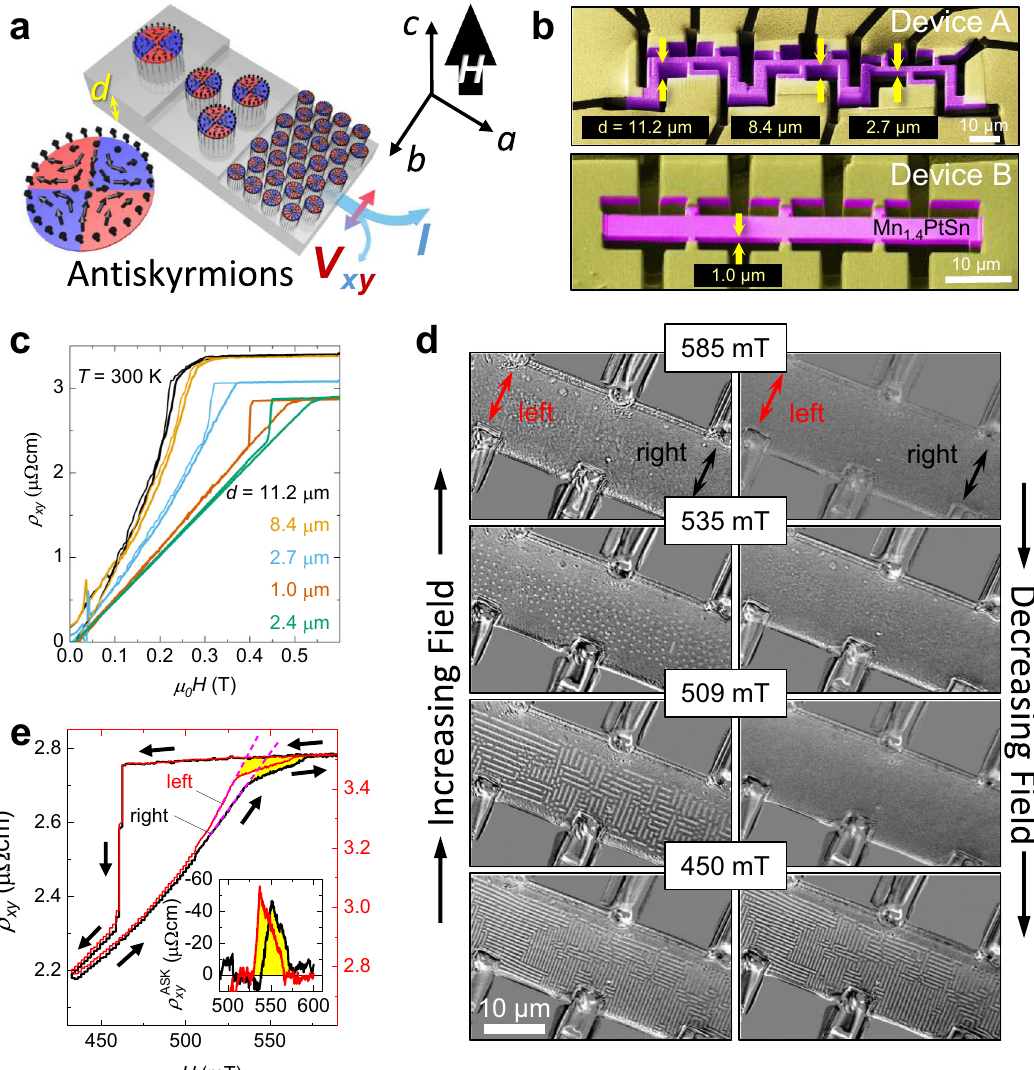
Fig. 1 Transport signature of ASKs in micro-fabricated Mn 1.4 PtSn devices. a Schematic visualization of thickness-dependent ASKs induced by magnetic fi eld, H ∥ c axis, in a step-like sample with applied current along the a axis. b False-color SEM images of FIB devices A and B with meander-shape (three thicknesses: d = 11.2, 8.4, and 2.7 μ m) and Hall-bar geometry ( d = 1.0 μ m), respectively, contacted via sputter-deposited gold contacts. (Further details of all investigated devices, dimensions, and fabrication are presented in Supplementary Notes 1 – 3). c Hall-resistivity loop of samples A, B, and C with different thicknesses, d , along the c direction with H ∥ c at T = 300 K. d Greyscale MOKE images of Hall-bar transport device F ( d = 0.8 μ m) at four different fi elds for up and down sweep, respectively. e In situ Hall loop for the left and right contacts of device F marked by red and black color, (FIB) assisted patterning, namely, a step-like device with thicknesses d = 11.2, 8.4, and 2.7 μ m and a standalone device with d = 1.0 μ m. In Fig. 1c, we display the total measured Hall effect for all thicknesses from the demagnetized state ( μ 0 H = 0) up to a nearly saturated state ( H S ). For d < 8.4 μ m, a noticeable hysteresis appears in the Hall effect before saturation, which details a noncoplanar magnetic and ASK spin texture, when the fi eld is applied parallel to the c axis. Device F with d = 0.8 μ m was set up as a Hall bar to simultaneously measure the Hall voltage while observing the magnetic state in situ via polar magneto- optical Kerr effect (MOKE) microscopy 41 . Selected MOKE images of the device are presented in Fig. 1d. The Hall data in Fig. 1e were simultaneously measured with polar MOKE microscopy, shown in Fig. 1d as a function of external fi eld.